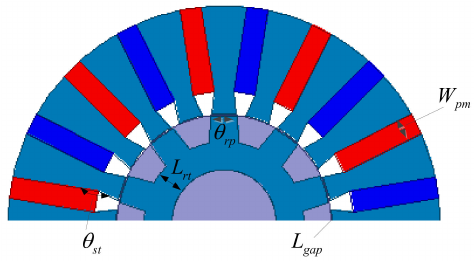
Figure 8. Design parameters for the